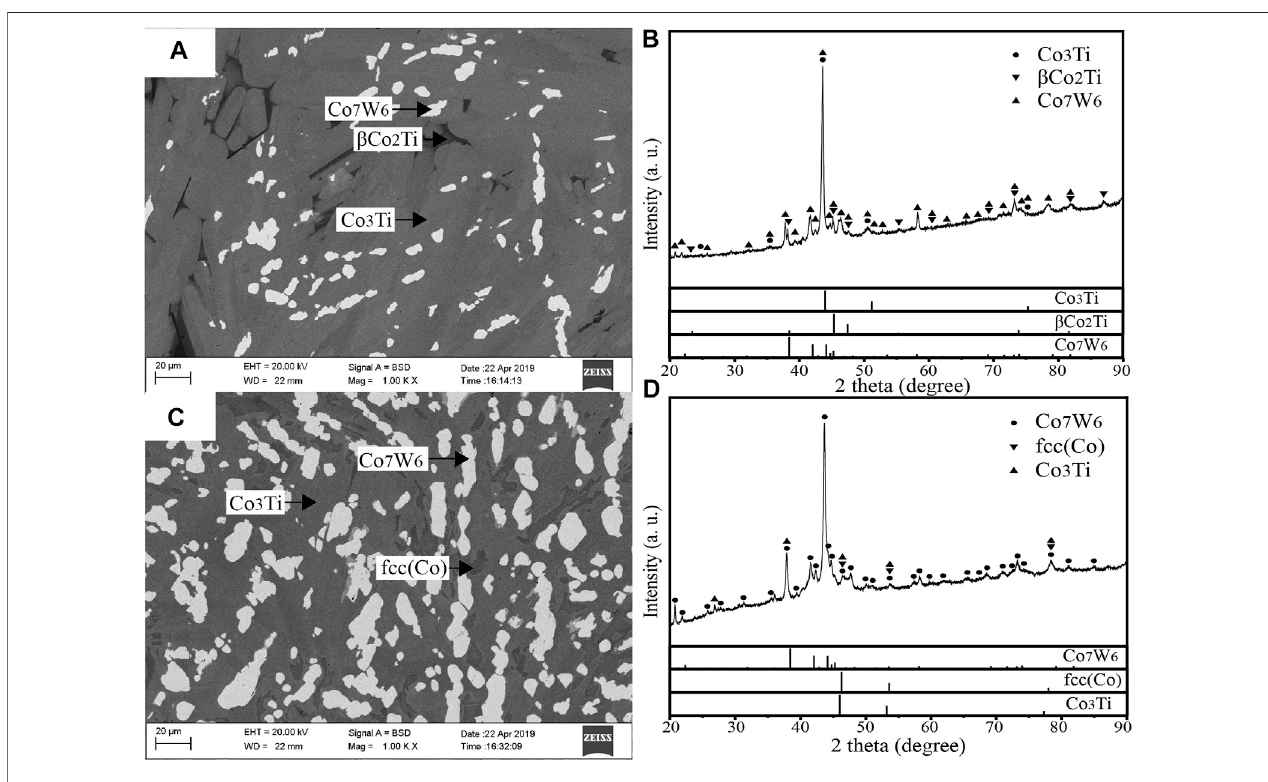
FIGURE 8 | BSE micrographs and XRD patterns of alloys (A) and (B) for b3 (C) and (D) for b4.